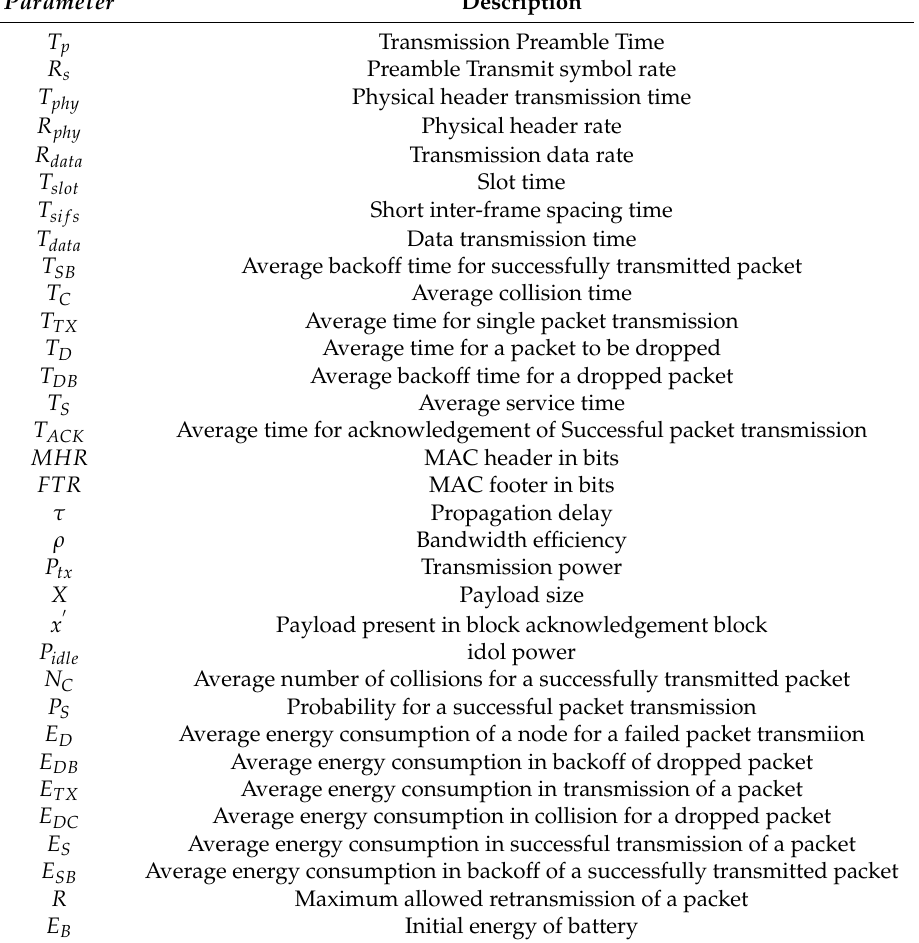
Table 3. List of